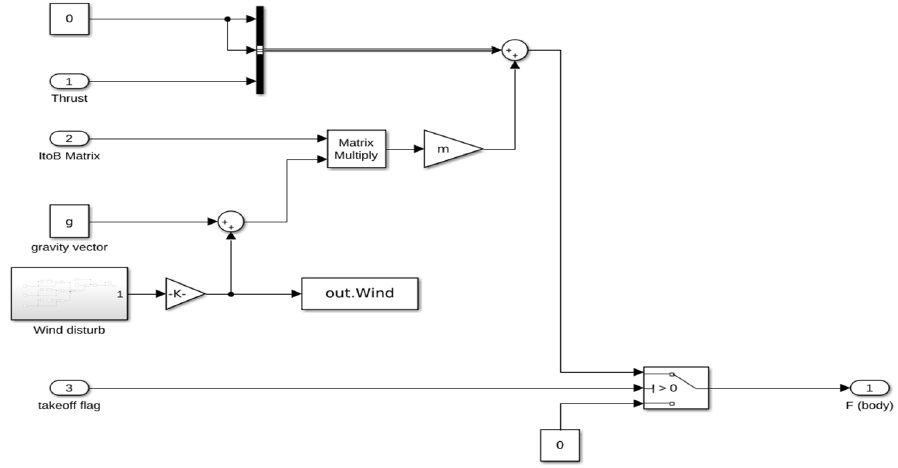
Figure 11. Forces acting on the Drone.